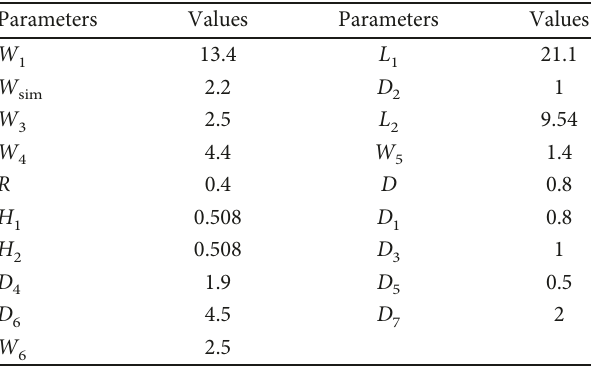
| for the computed HMSIW, 11